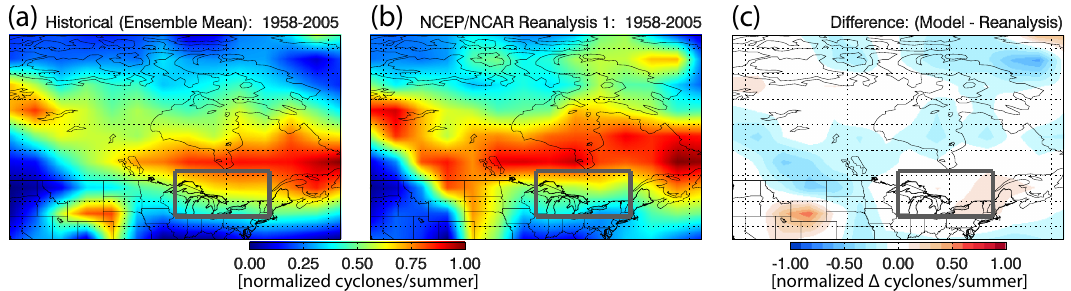
Fig. 2. Spatial distribution of cyclone tracks during summer (JJA) from 1958–2005. Storms are counted per 5 ◦ × 5 ◦ box as is done in Leibensperger et al. (2008) and then normalized (data are shifted to a minimum of zero and then scaled by the maximum cyclone fre- quency) to account for offsets between datasets. (a) GFDL CM3 ensemble mean from the historical runs. (b) NCEP/NCAR Reanalysis 1 climatology. (c) Difference between (a) and (b) .